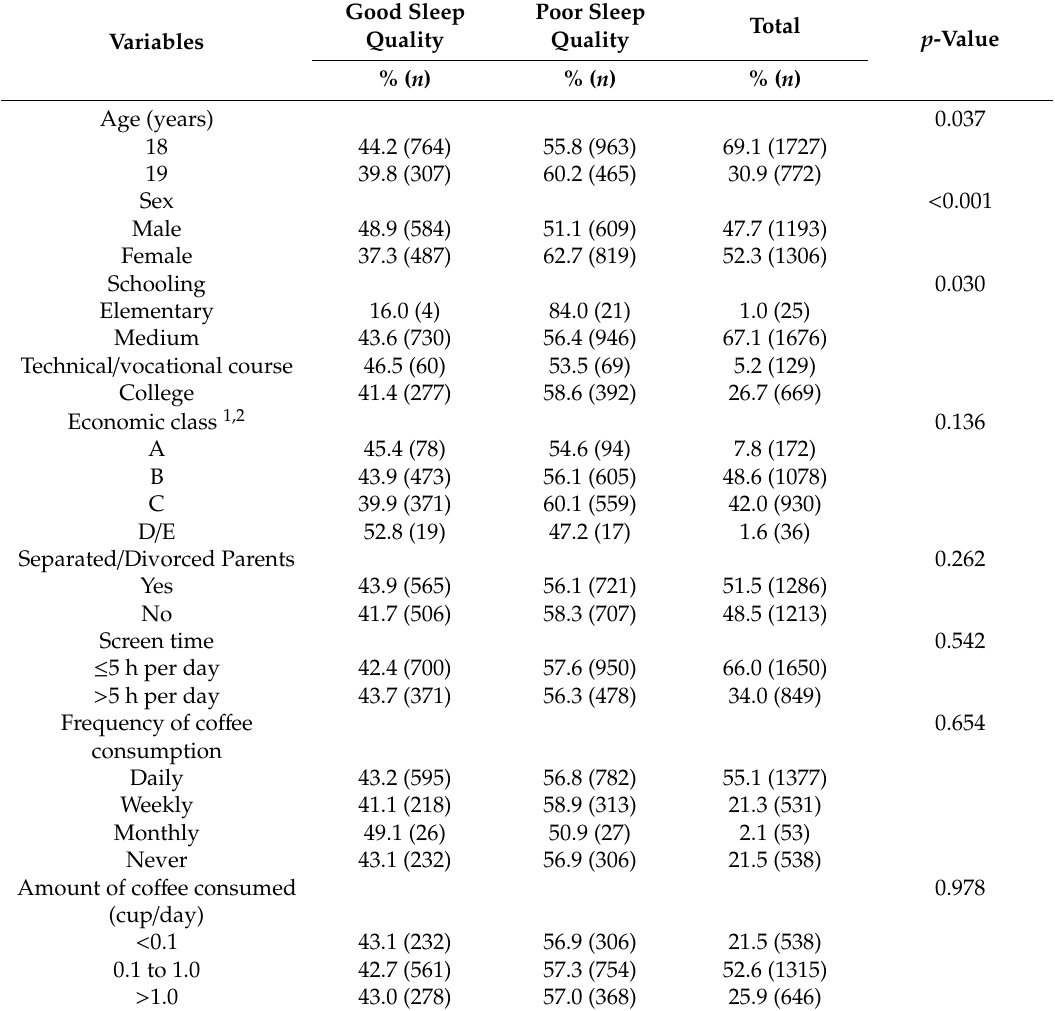
Table 1. Sociodemographic and lifestyle characteristics according to sleep quality of adolescents, S ã o Lu í s, Maranh ã o, Brazil,